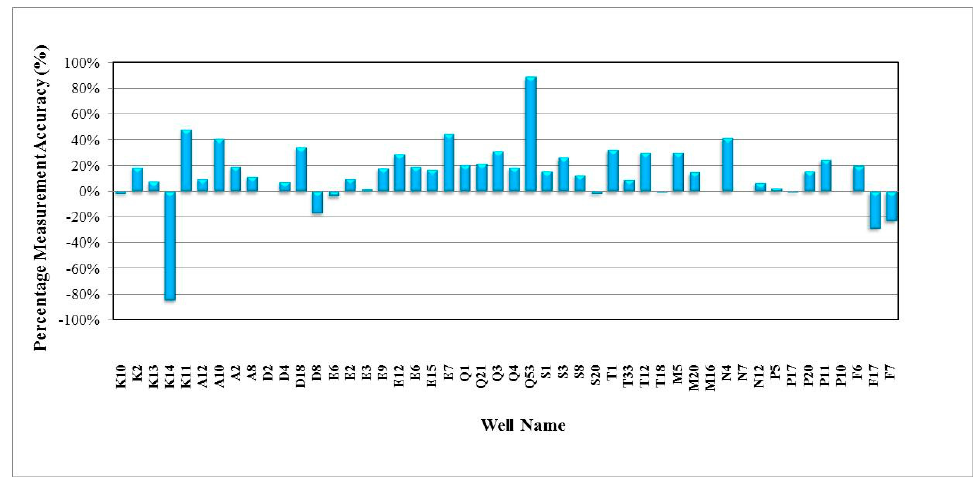
Figure 23. Oil rate measurement accuracy using the Colebrook correlation.